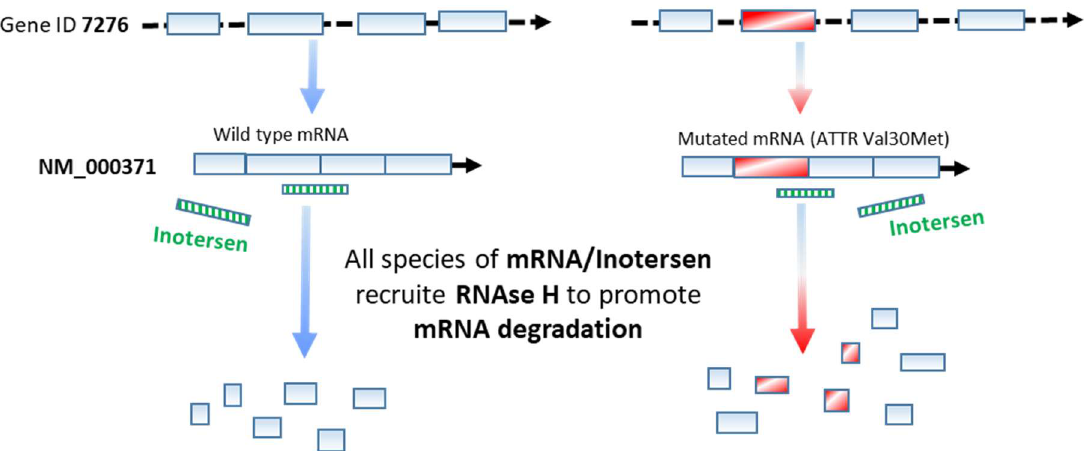
Figure 1. siRNA treatment to silence the ephrin-A receptor 2 (EphA2). The gene is located on chromosome 1p36.13; exons, 18; NM_004431; NP_004422. A detailed description is reported in the text.